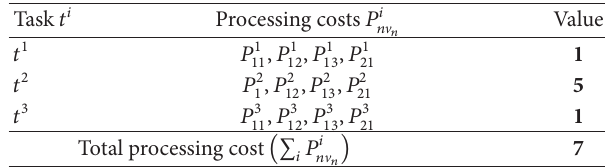
Figure 2: Cloud architecture. Table 1: Task processing